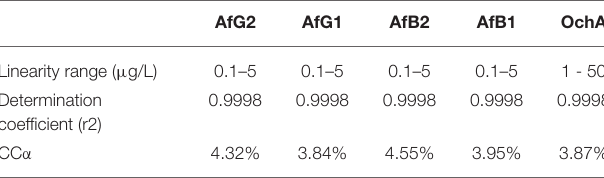
TABLE 3 | Characteristics of the linear regression